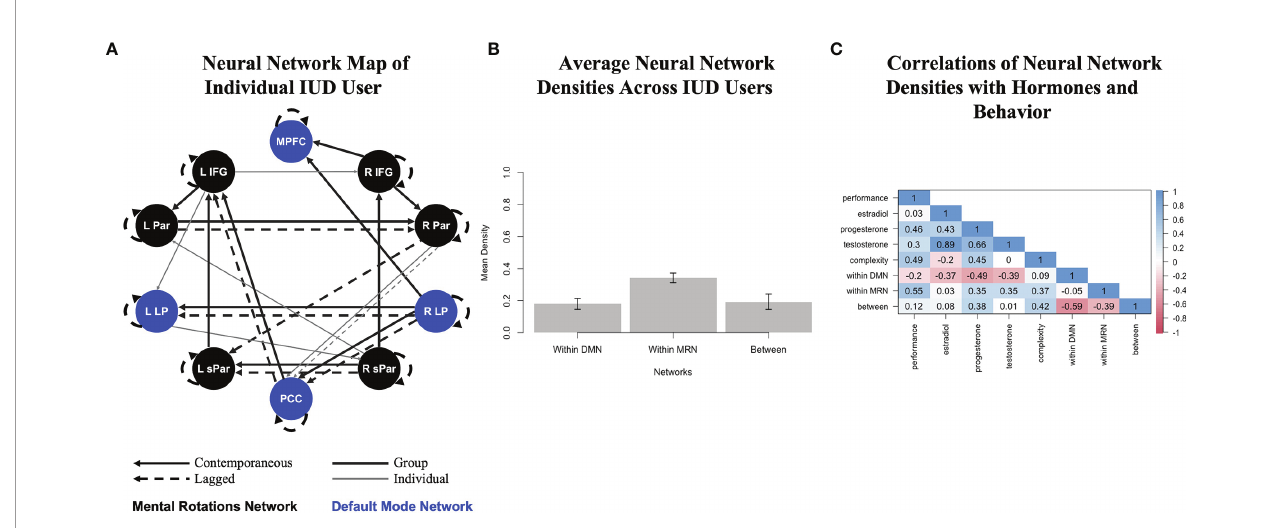
FIGURE 1 | Analysis pipeline linking multimodal data in IUD users who completed a mental rotations fMRI task and provided saliva for hormone assays. (A) A person- speci fi c neural network generated by group iterative multiple model estimation (GIMME) for one IUD user. Black nodes show putative mental rotations network regions, and blue nodes show default mode network regions. Solid lines are contemporaneous (same-volume) connections, and dashed lines are lagged (next-volume) connections. Thick black lines are group-level connections signi fi cant for at least 75% of the sample, but estimated for all IUD users, and thin gray lines are individual-level connections unique to this IUD user; all participants had corresponding estimated networks (though not depicted here). All connections also have a direction (positive or negative) and beta weight associated with them (also not depicted here). This woman ’ s network fi t her functional data well ( c 2 (112)=652.60, p <.001, RMSEA=.135, SRMR=.039, CFI=.955, NNFI=.924). R, right; L, left; IFG, inferior frontal gyrus; Par, parietal; LP, lateral parietal; sPar, superior parietal; MPFC, medial prefrontal cortex; PCC, posterior cingulate cortex. (B) Average neural network densities extracted from the person-speci fi c GIMME networks of all IUD users (and divided by overall network complexity), with error bars showing standard deviations. (C) Correlations among multimodal data, including mental rotations task performance in the scanner, endogenous hormone levels, and neural network features, including overall complexity and network densities. Color-coded correlations are shown in the matrix, with dark red re fl ecting strong inverse relations through dark blue re fl ecting strong positive